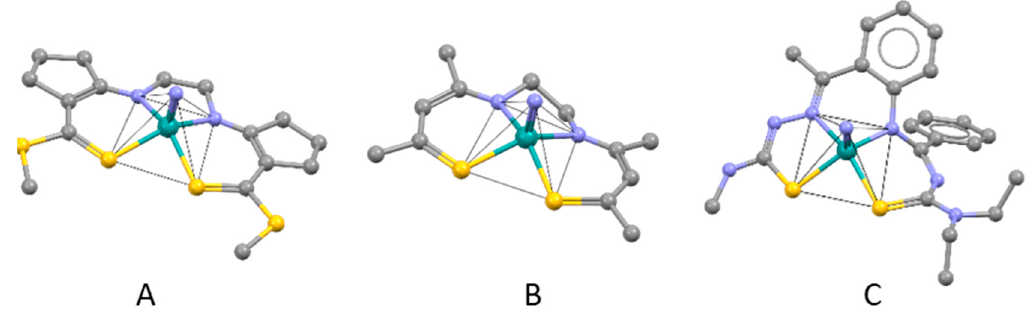
Figure 5. Structure of TcN(eacyd) ( A ), TcN(etaai) ( B ), and TcN(tcbatsc) ( C ).